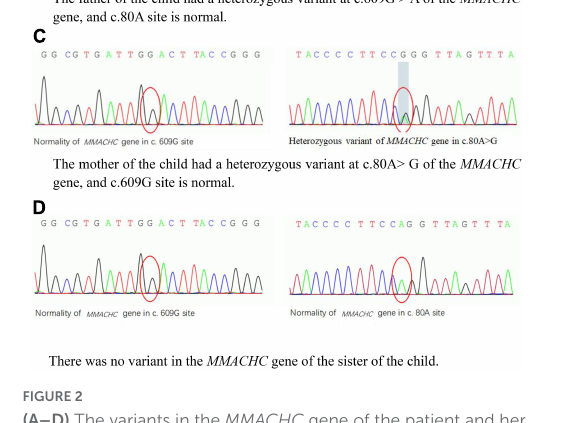
FIGURE2 (A–D) The variants in the MMACHC gene of the patient and her family. HGB, hemoglobin; SCr, serum creatinine; SHcy,